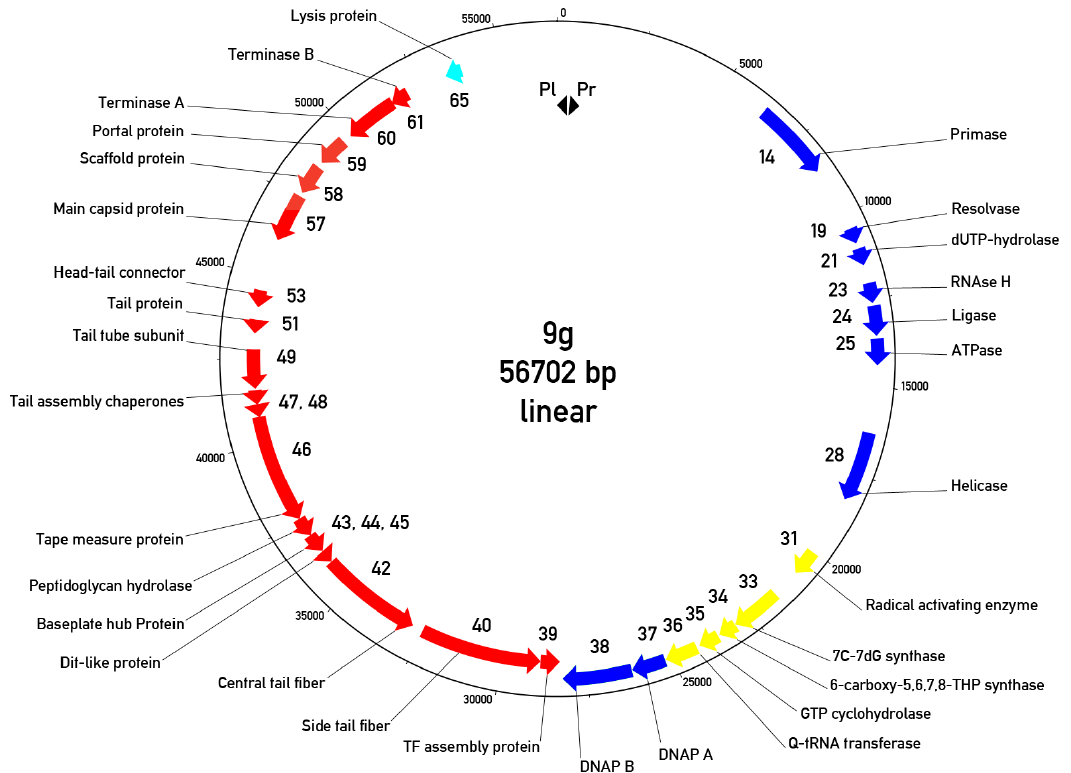
Figure 7. Circularized genomic map of bacteriophage 9g. The “0” is placed at the putative left end of the encapsidated virion DNA. Only the genes with predicted functions are indicated. Cyan arrow—Lysis protein, red arrows—Morphogenetic proteins, blue arrows—DNA metabolism proteins, yellow arrows—Queosine synthesis gene cluster. Pl and Pr—Left and right